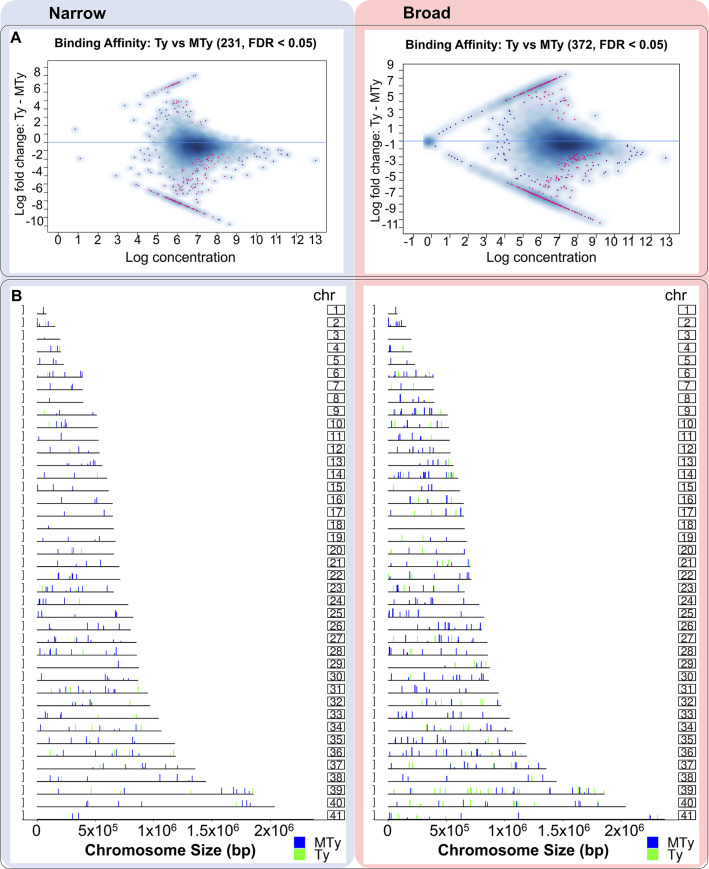
MAplot and localization of enriched regions throughout the Chromosomes.A—MAplots depict the enriched regions prevalent in MTy or Ty samples detected by MACSauto, with FDR 5% for Narrow (left) or Broad (right). The purple dots correspond to those regions enriched in MTy or Ty with FDR < 5%. B—Coverage plot representing the position of the Narrow (left) and Broad (right) enriched sequences obtained by MACSauto_FDR5%. The prevalent regions in MTy (blue bars) and in Ty (green bars) are represented throughout the 41 chromosomes (chr) of the T. cruzi CLBrener Esm-like haplotype. The height of each bar is relative to fold change values calculated by the DiffBind program.